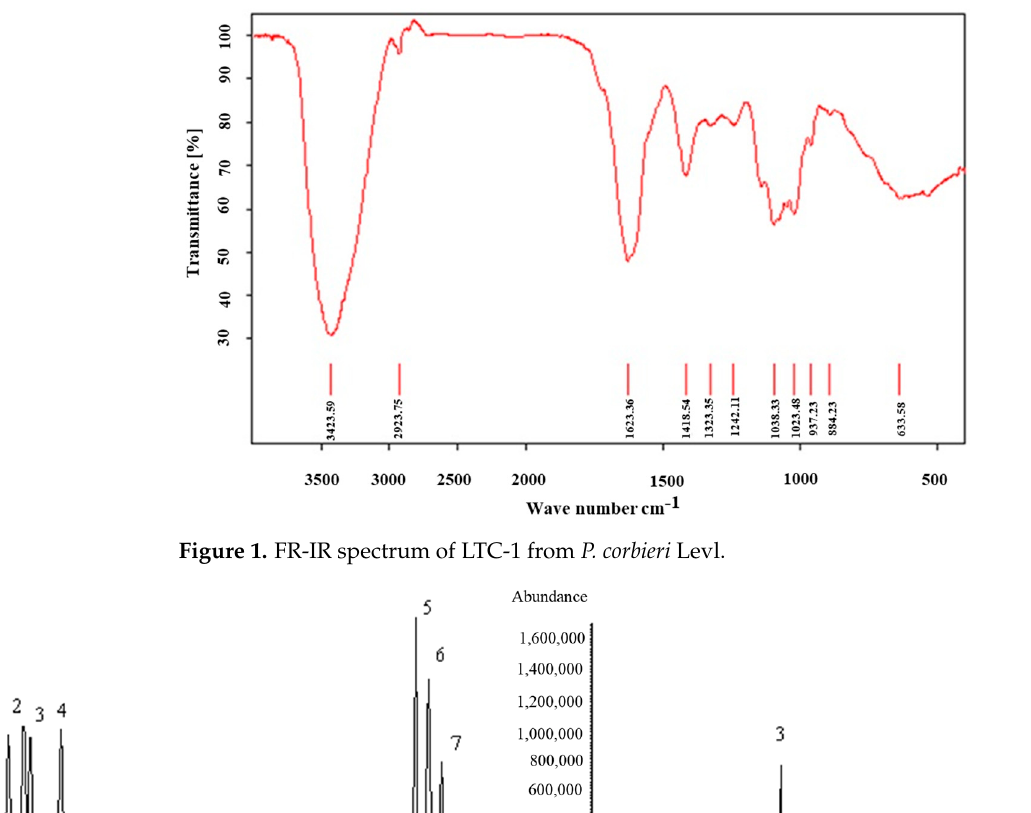
Figure 1. FR-IR spectrum of LTC-1 from P. corbieri Levl.